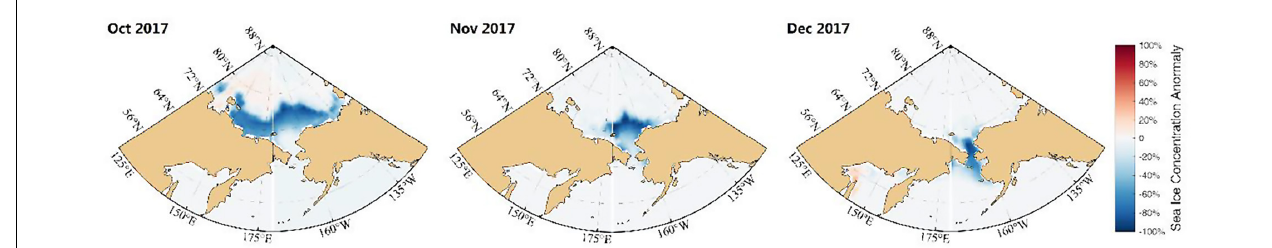
FIGURE 2 | Sea ice concentration anomalies during the freezing season (October–December) in